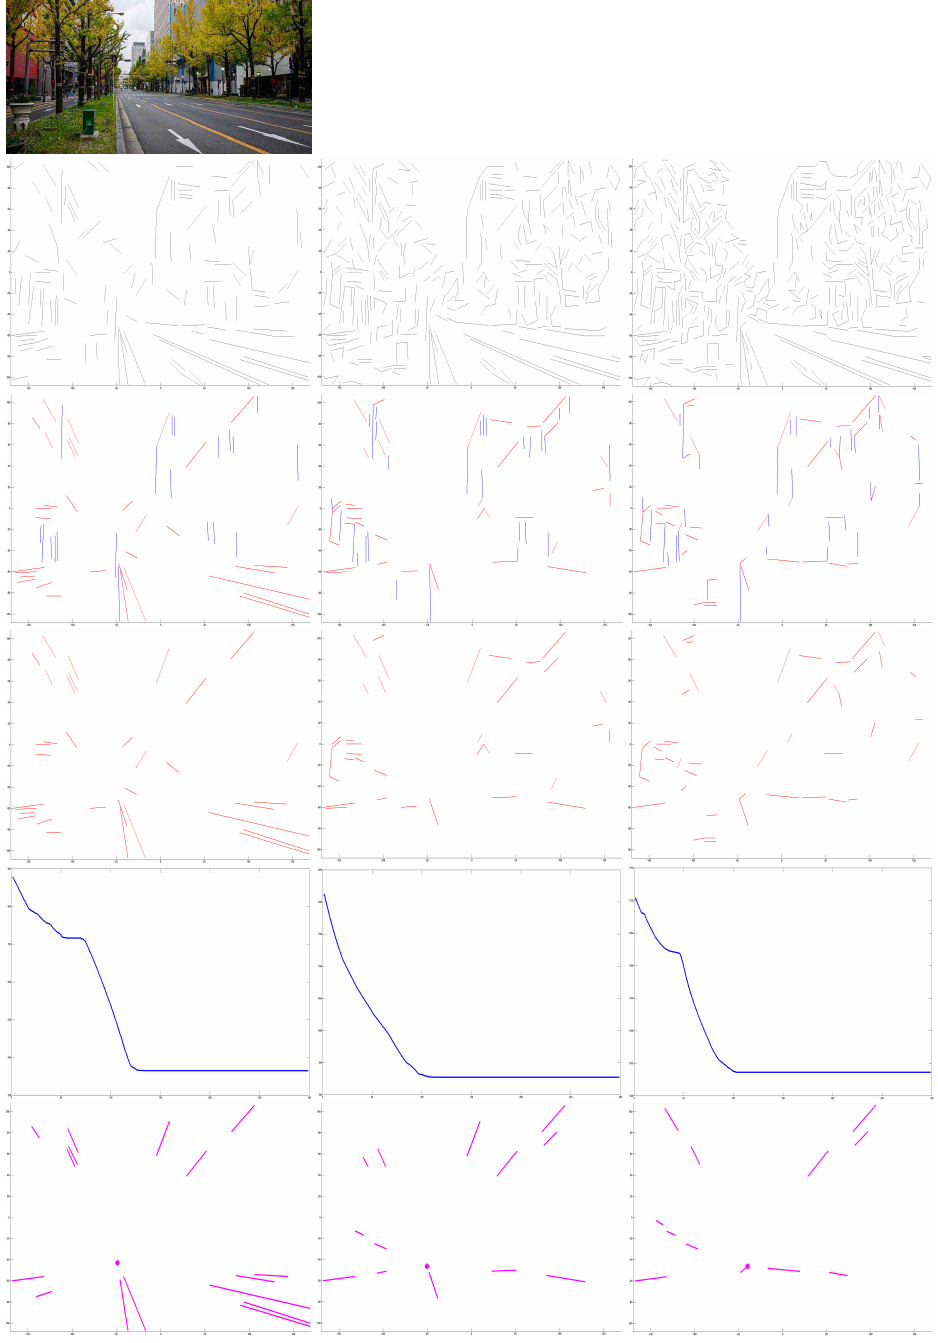
Figure 3. Experimental results for different numbers of detected lines. First row : input. Second row : growing numbers of detected lines. Third row : extracted compositions of lines. Fourth row : refined lines. Fifth row : convergence in optimal estimation. Bottom row : VPs estimated by our method. With the growing number of detected lines, it is clear that our approach has robustness in estimating VP by refining lines for different detected